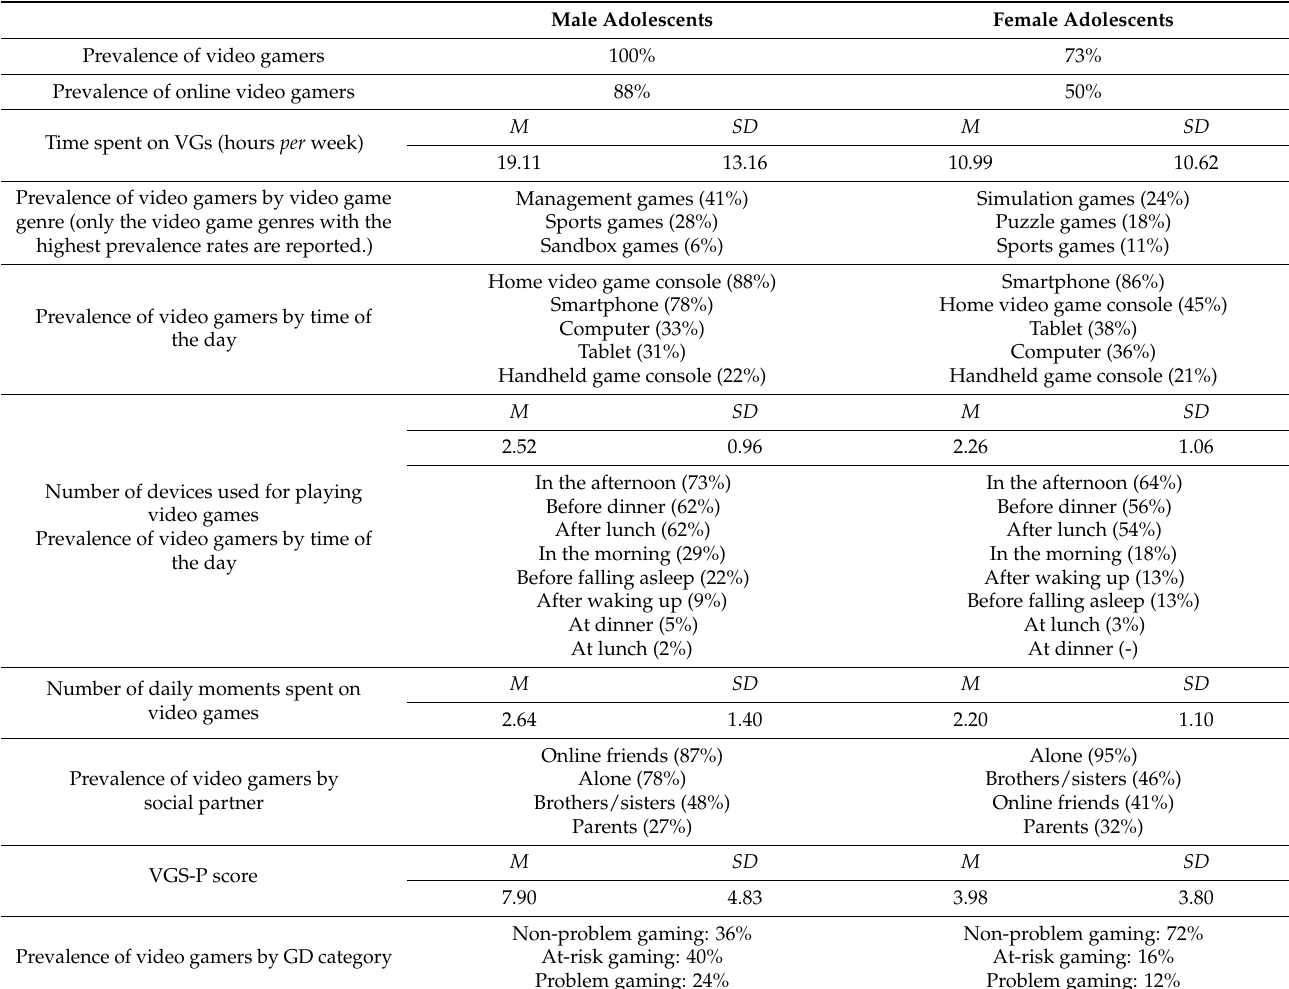
Table 2. Gaming habits of adolescents based on gender. Male Adolescents Female Adolescents Prevalence of video